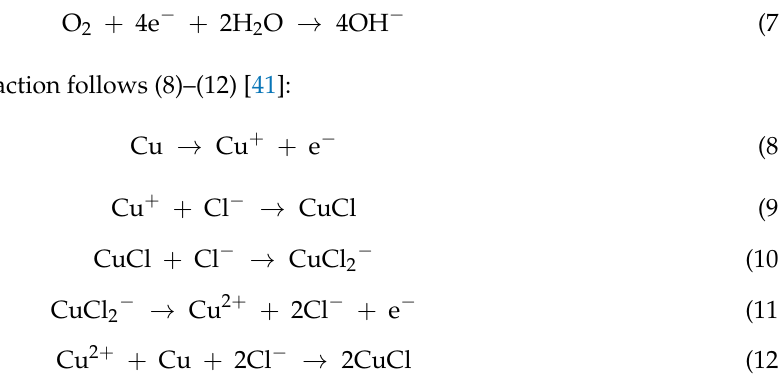
Table 2. The cathodic reaction on copper surface in NaCl solution is Equation (7)